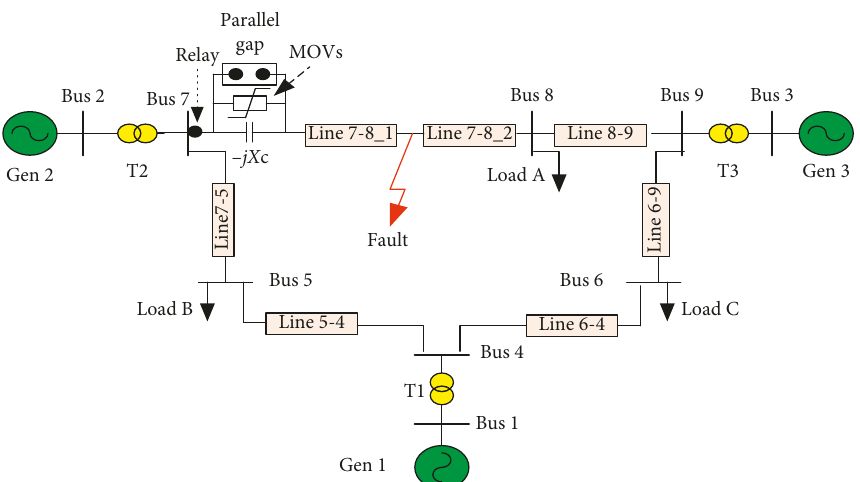
Figure 12: Single-line diagram of the modified WSCC 3-machine 9-bus system.